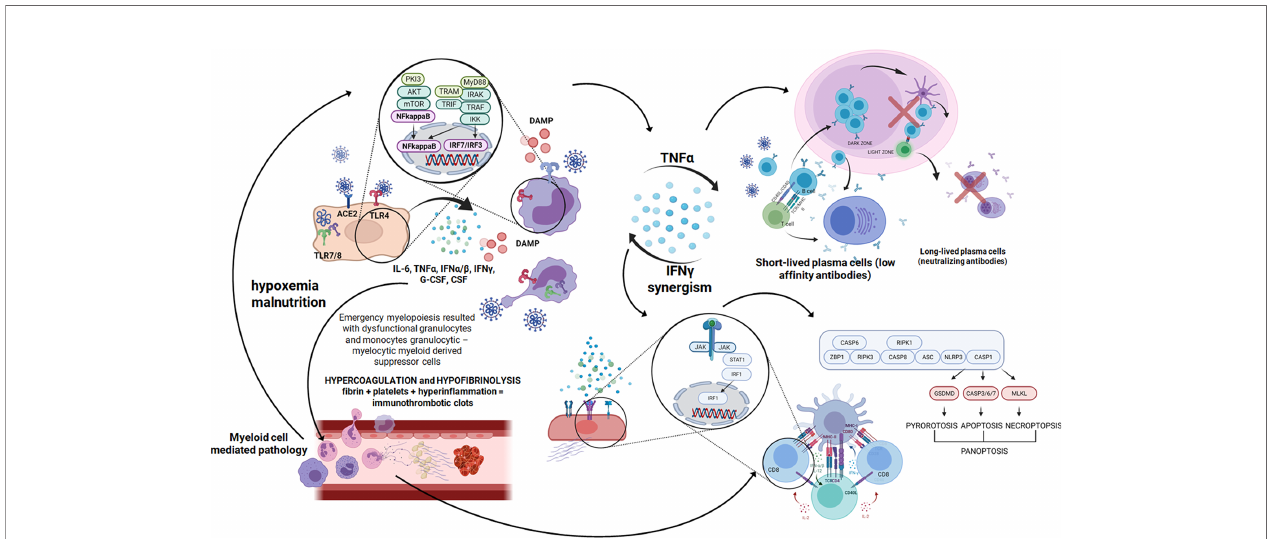
FIGURE 3 | A cascade of events after SARS-CoV-2 infection starts with a few days time lag in which the virus replicates using a set of open frame genes in airway epithelial cells (70). Then pneumocytes are invaded and huge amount of DAMPS are released (71). After that innate immunity receptors recognize viral RNA and proin fl ammatory cytokines are produced using the NFkappaB signaling pathway. Pyroptosis is seen and proin fl ammatory cytokines build up an in fl ammatory response (72). Then macrophages, monocytes and polymorphonuclear leukocyte are recruited and activated in the in fl ammatory environment and the next wave of cytokines surges. In severe COVID-19 cases as a result of emergency myelopoiesis dysfunctional mature neutrophils and HLADRlow monocytes appear in the blood (73). In this complex situation the endothelial cell infection outcome contributes additionally to the in fl ammatory response. Endothelial damage leading to thrombolytic microangiopathy causes hypoxemia and malnutrition (43). The mTOR pathway is activated, which ends up with NFkappaB and massive cytokine release (74). Created in